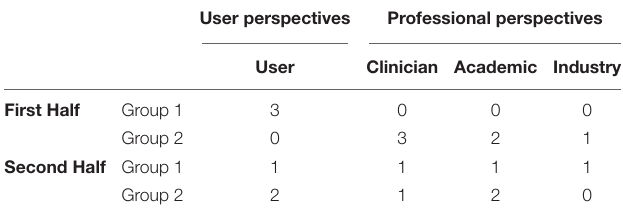
TABLE 1 | Workshop 1 groups.